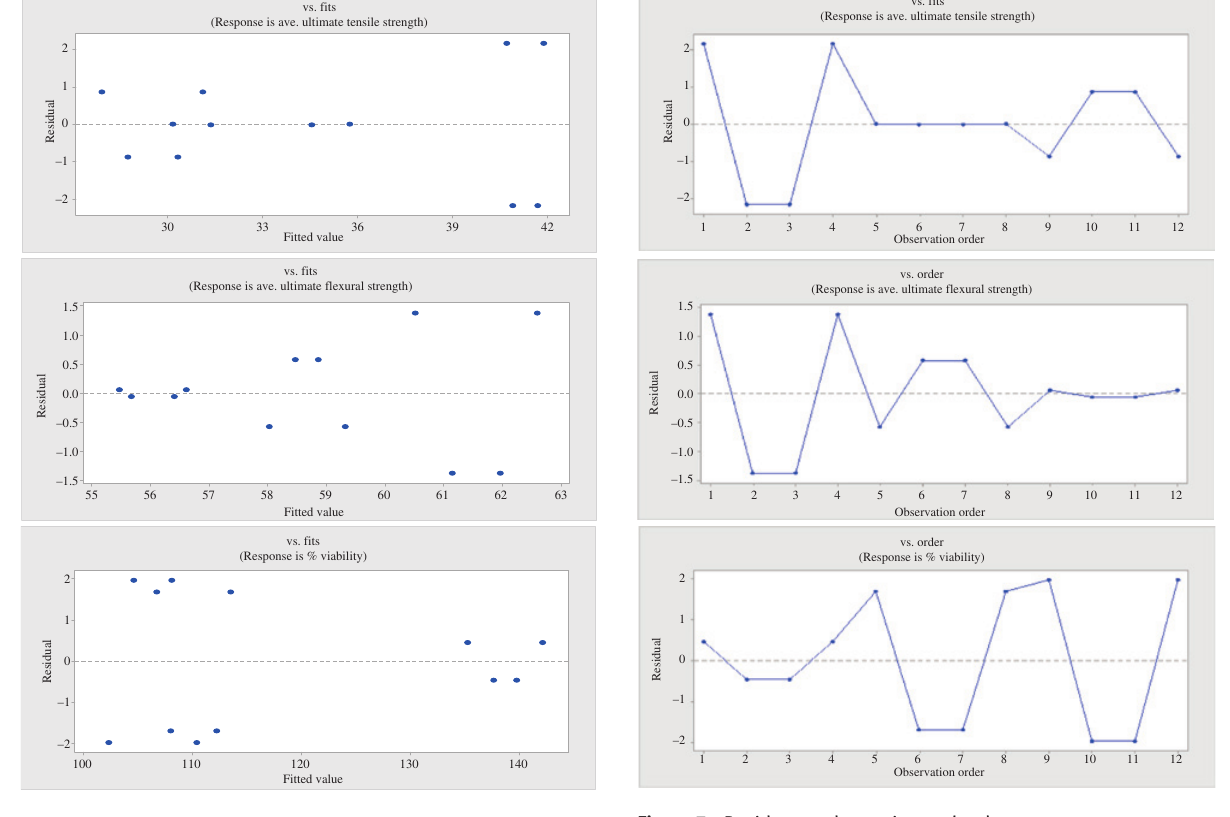
Figure 6: Residual distribution. Figure 7: Residues and experimental order.